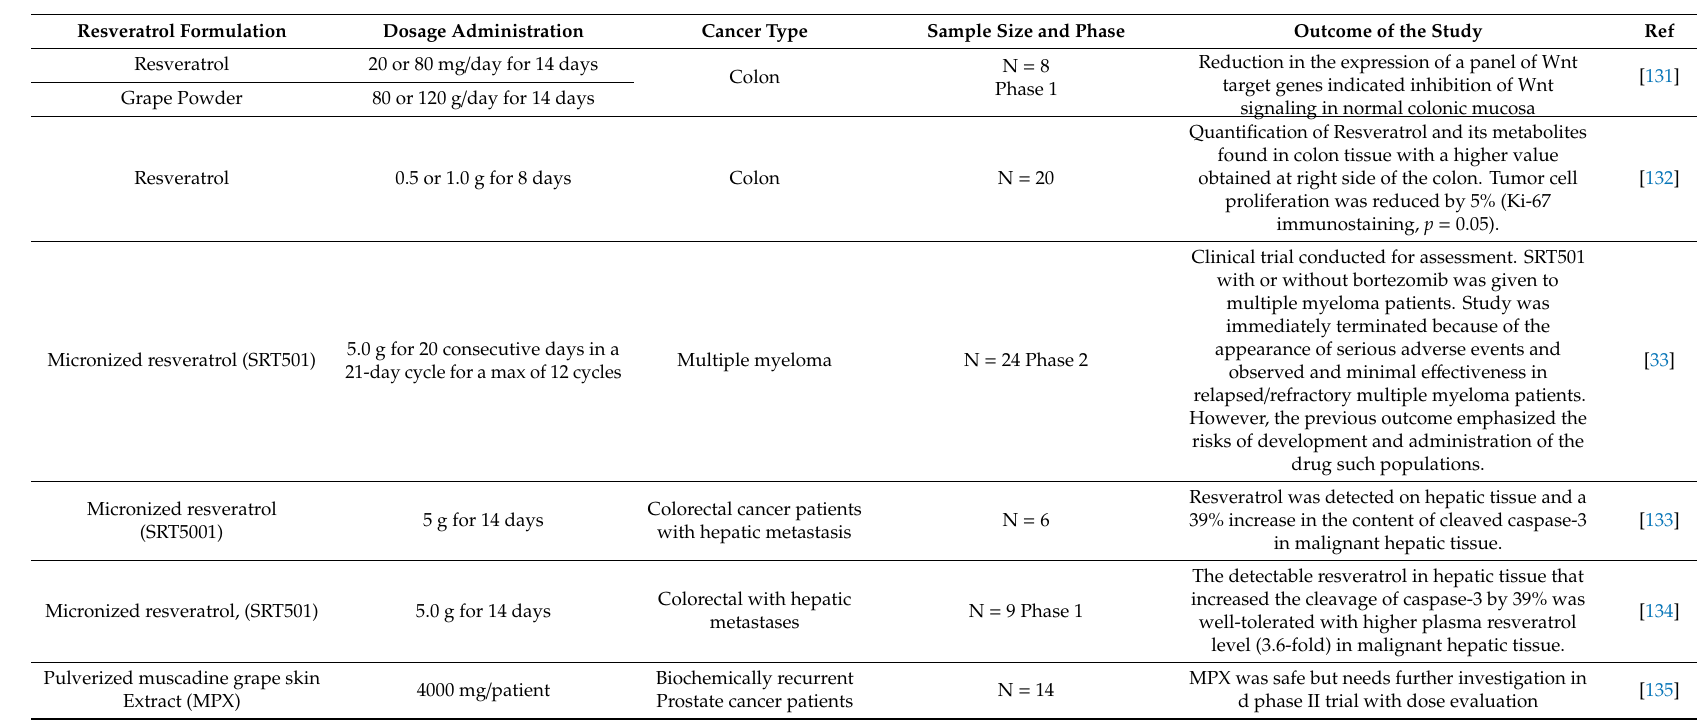
Table 3. Published human studies evaluating the e ff ects of resveratrol on cancer cells as reported in the last 12